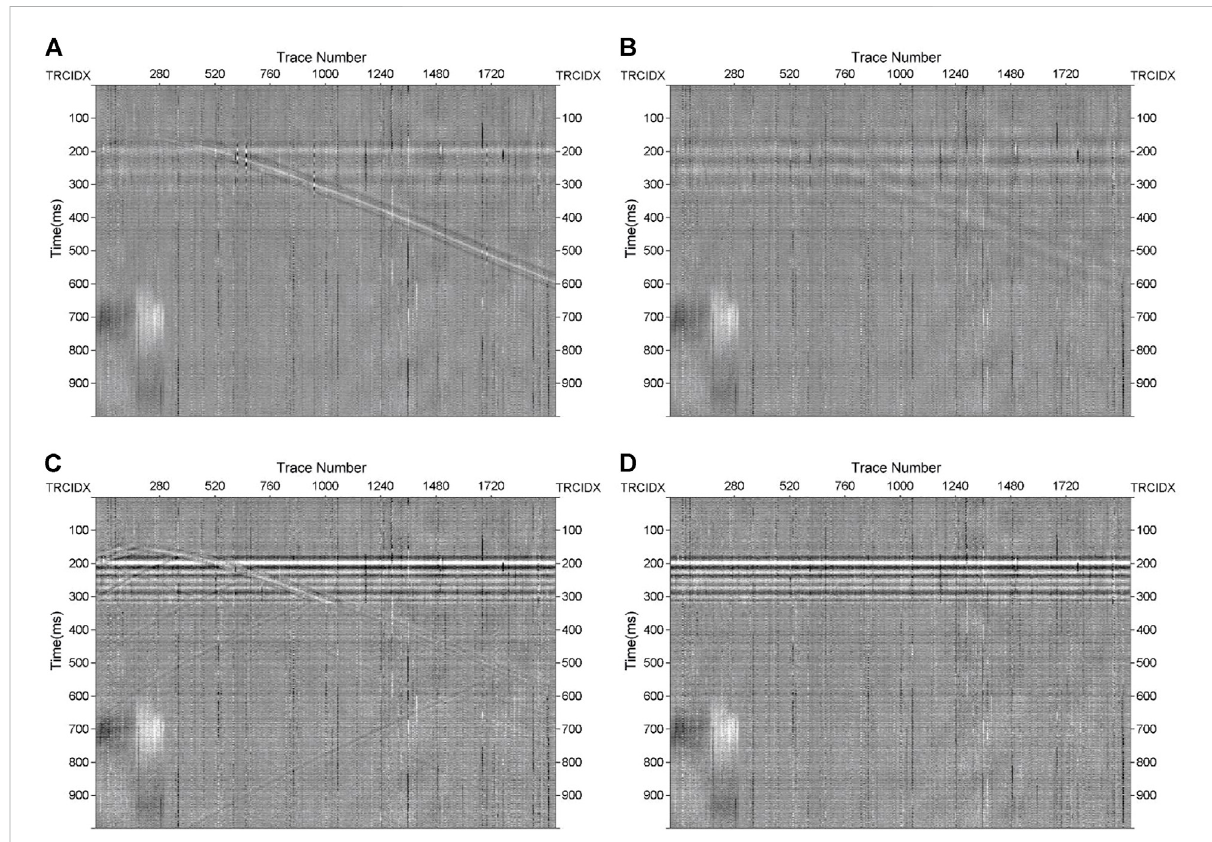
FIGURE 7 Difference maps from the four denoised results. (A) Difference map from VMD, (B) difference map from band-pass fi ltering, (C) difference map from DnCNNs, (D) difference map from